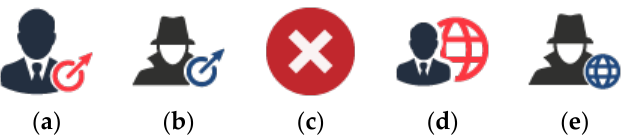
Figure 8. Visual representation of attacking agents and situations in the BPMN extension. ( a ) un-intentional external agent, ( b ) Intentional external agent, ( c ) System error, ( d ) Un-intentional internal agent, ( e ) Intentional internal